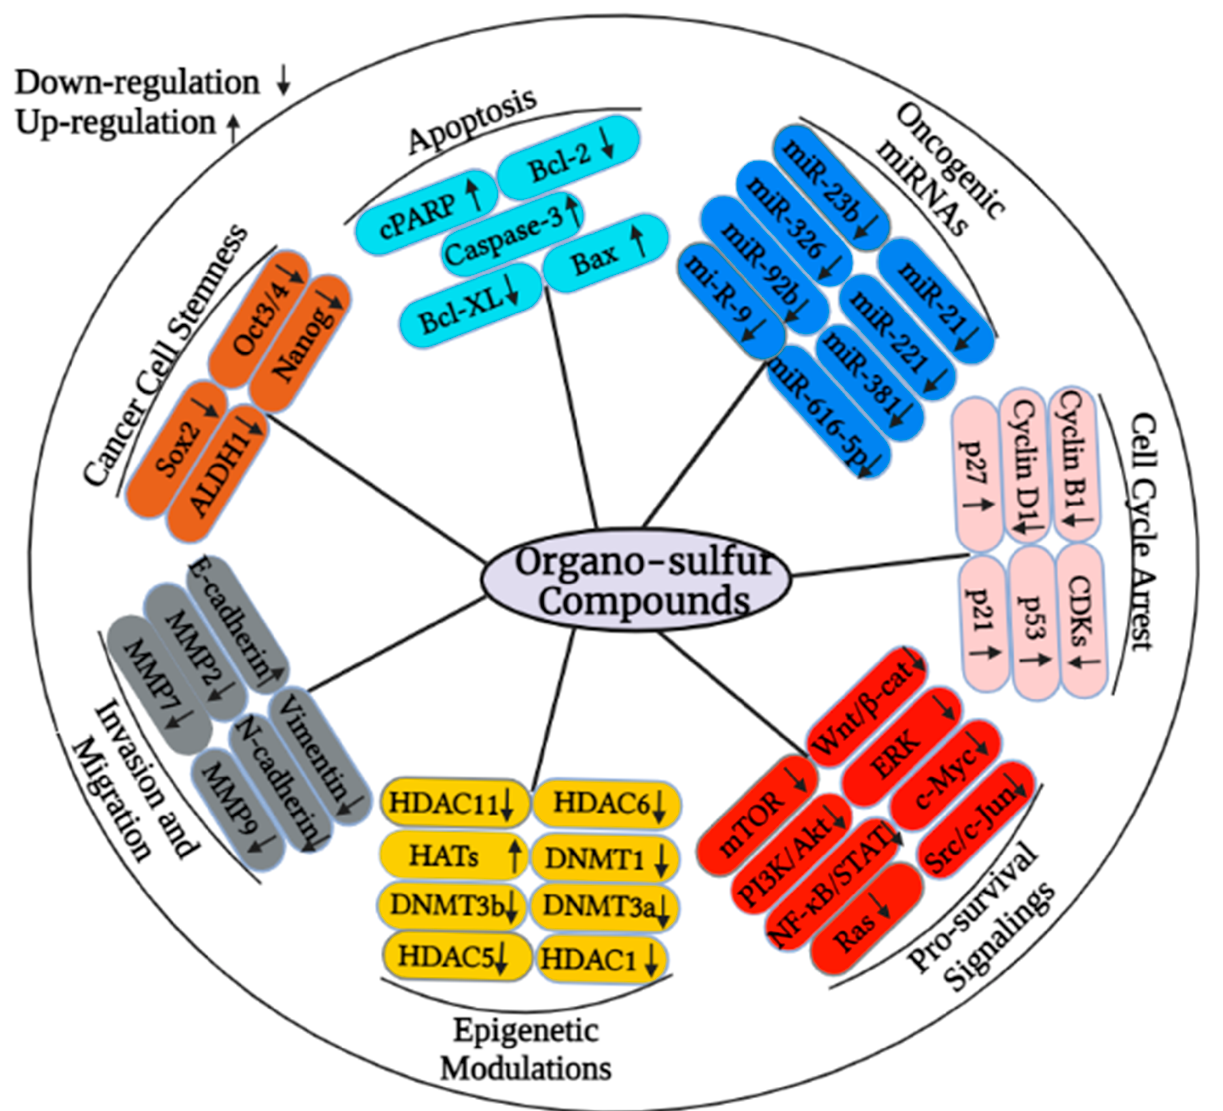
Figure 2. Organo-sulfur compounds can change the expression of various cancer-associated proteins though the modulating of epigenetic mechanisms. In particular, organo-sulfur compounds may target the activity of HDACs and DNMTs to suppress the proliferation-, metastasis-, cell cycle progression, and pro-survival-associated signaling molecules. These compounds can also target the regulation of micro RNAs to restrict the cancer growth.